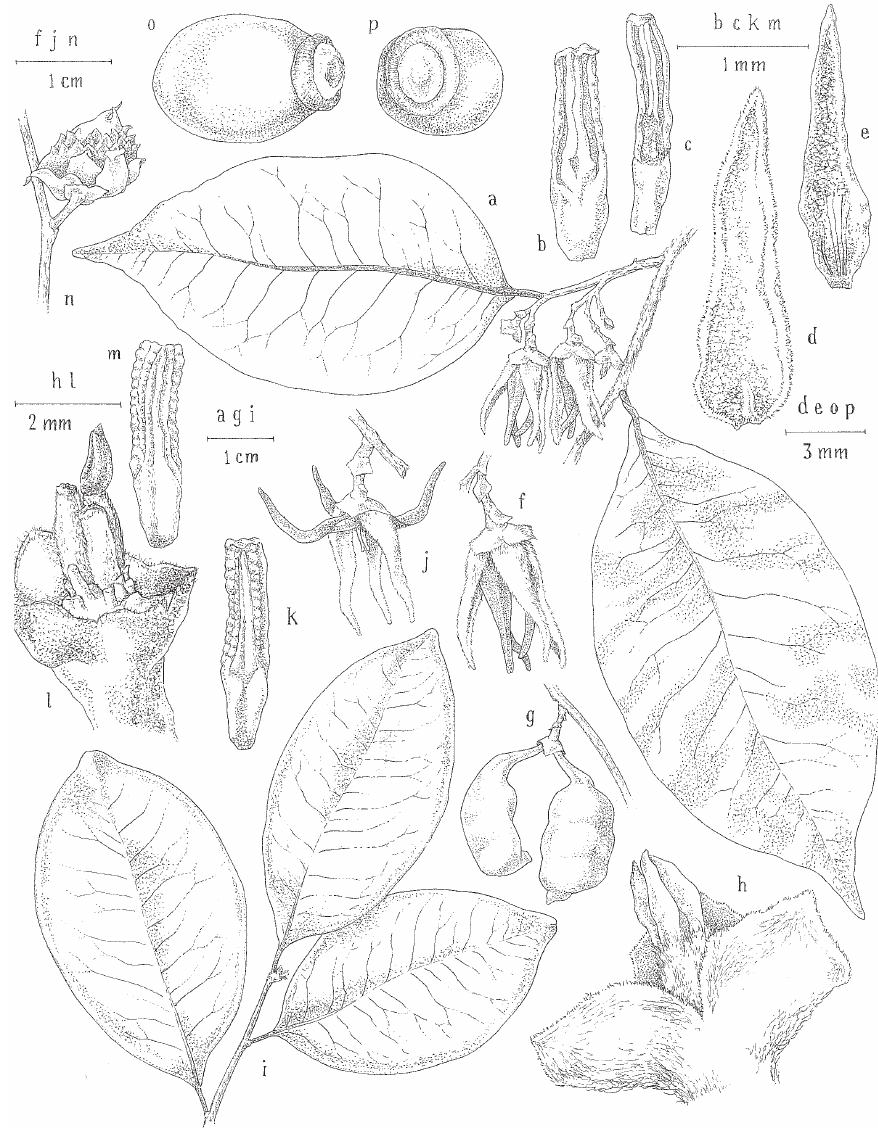
Figure 18. Xylopia lukei and X. mwasumbii . A–F, H X. lukei A Habit B, C Stamens, abaxial view D Outer petal, adaxial view E Inner petal, adaxial view F Flower, side view H Flower with petals removed, showing carpels G, I–P X. mwasumbii G Fruit I Leaves J Flower, side view K, M Stamens, abaxial view L Gynoecium and surrounding staminal cone N Flower gall O Seed with aril removed, side view P Seed with aril re- moved, view of micropylar end. A–F, H from Luke et al. 10166 (MO) G from Johnson & Ndangalasi 1899 (OWU) I, J from Johnson 1920 (OWU) K–M from Johnson 1928A (OWU) N from Johnson & Ndangalasi 1948 (OWU) O, P from Johnson & Ndangalasi 1884 (OWU) K–M, O, P were drawn from ethanol- preserved material and so have dimensions slightly greater than those in the description, which is based on dried specimens. Reproduced with the permission of the Board of Trustees, Royal Botanic Gardens